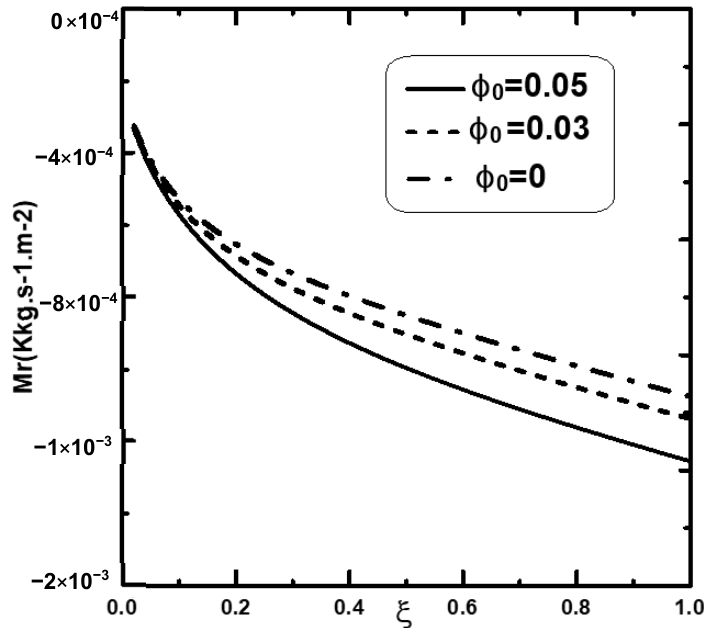
Figure 4. Effect of inlet nanoparticles volume fraction on the cumulated condensation rate: T 0L =293.15 K, T 0 =293.15 K, q 1 = − 1000 W/m 2 , T w =293.15 K, c 0 =0.3, u 0 =1 m/s, m 0L =0.015 kg/m.s, H=1 m, d=0.015 m, p 0 =1 atm.